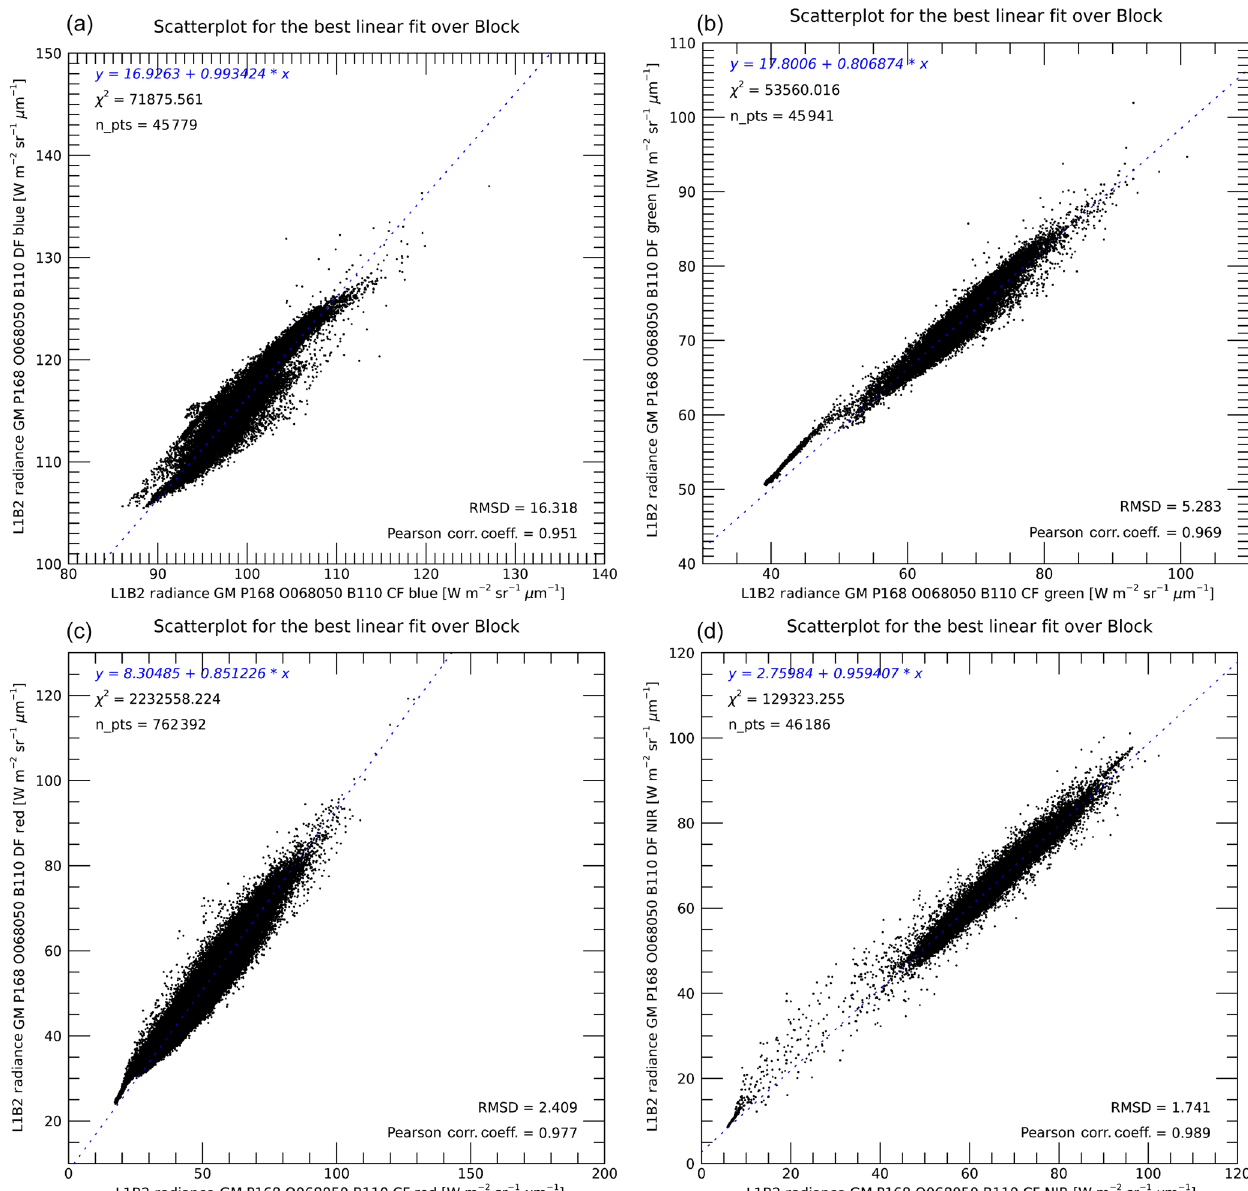
Figure 6. Scatterplots and best linear fit relationships to predict the radiance values of the four spectral bands of the target DF camera for the G LOBAL M ODE measurements of P ATH 168, O RBIT 68050 and B LOCK 110 using all common valid values. In this case, the best predictors for the measurements by the DF camera were those acquired by the CF camera in the same spectral bands as the targets ( a : blue; b : green; c : red; and d : NIR). Note that the ranges of values are different for each plot in order to optimize the view of the